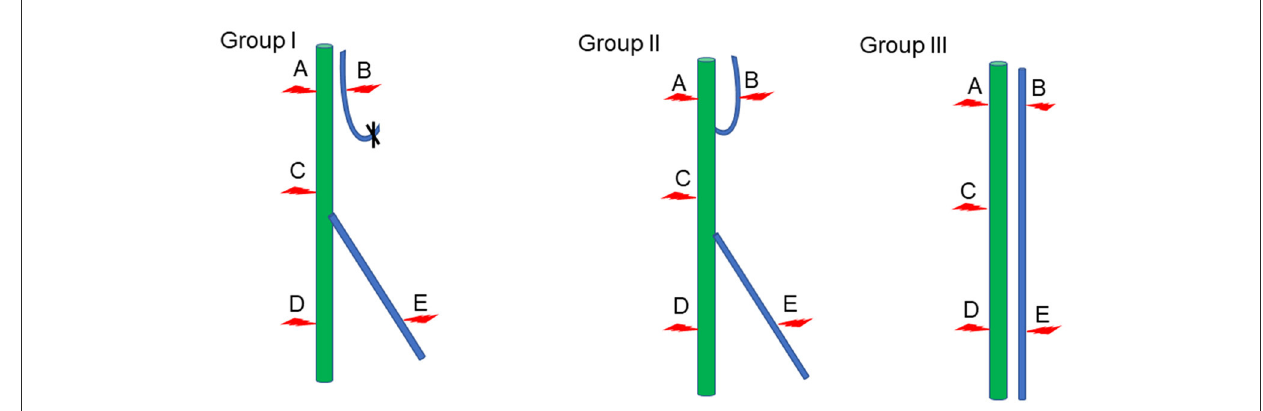
FIGURE1 Schematic diagram of electrophysiological detection. Green represents the tibial nerve, blue indicates the common peroneal nerve, and the red arrow denotes the location of the stimulation electrode.